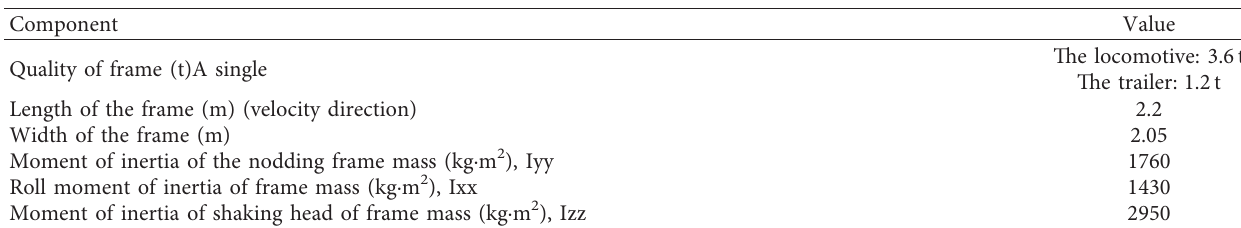
Table 2: Bogie frame parameters.